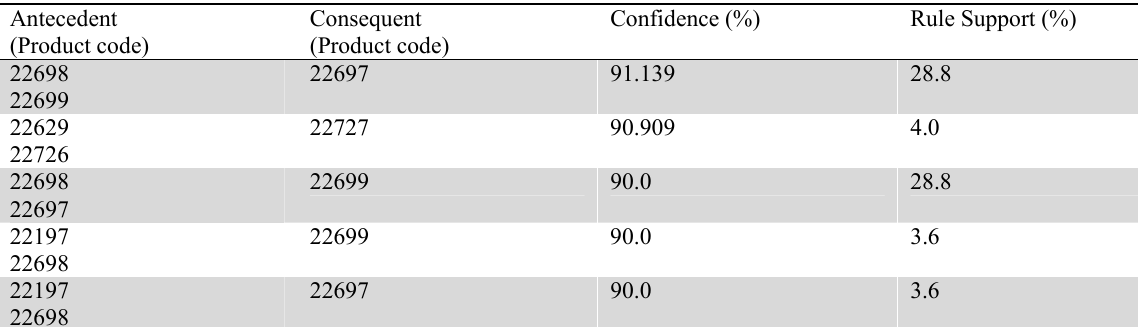
Association rules for scenario 8 in situation